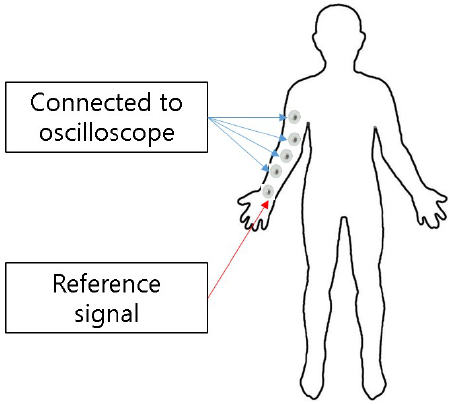
Figure 5. Experiment settings for propagation delay measurements.